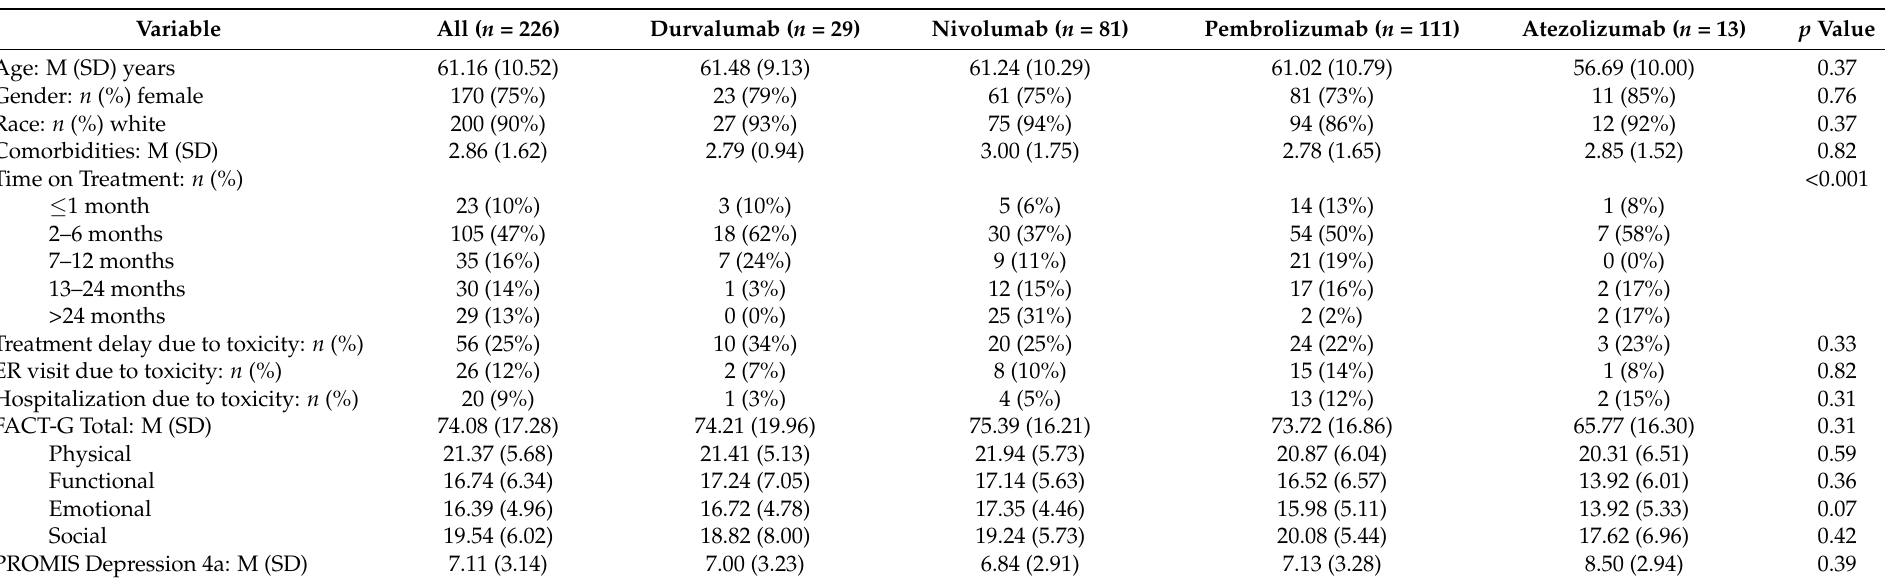
Table 1. Sociodemographic and clinical characteristics and patient-reported outcomes by immune checkpoint inhibitor received. Note: Some percentages do not equal 100 due to sporadic missing data.